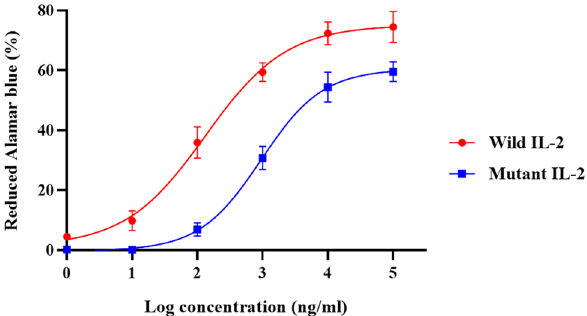
Figure 2. PBMC colorimetric proliferation assay. All experiments were done in triplicate. Data are represented as mean ± SD.